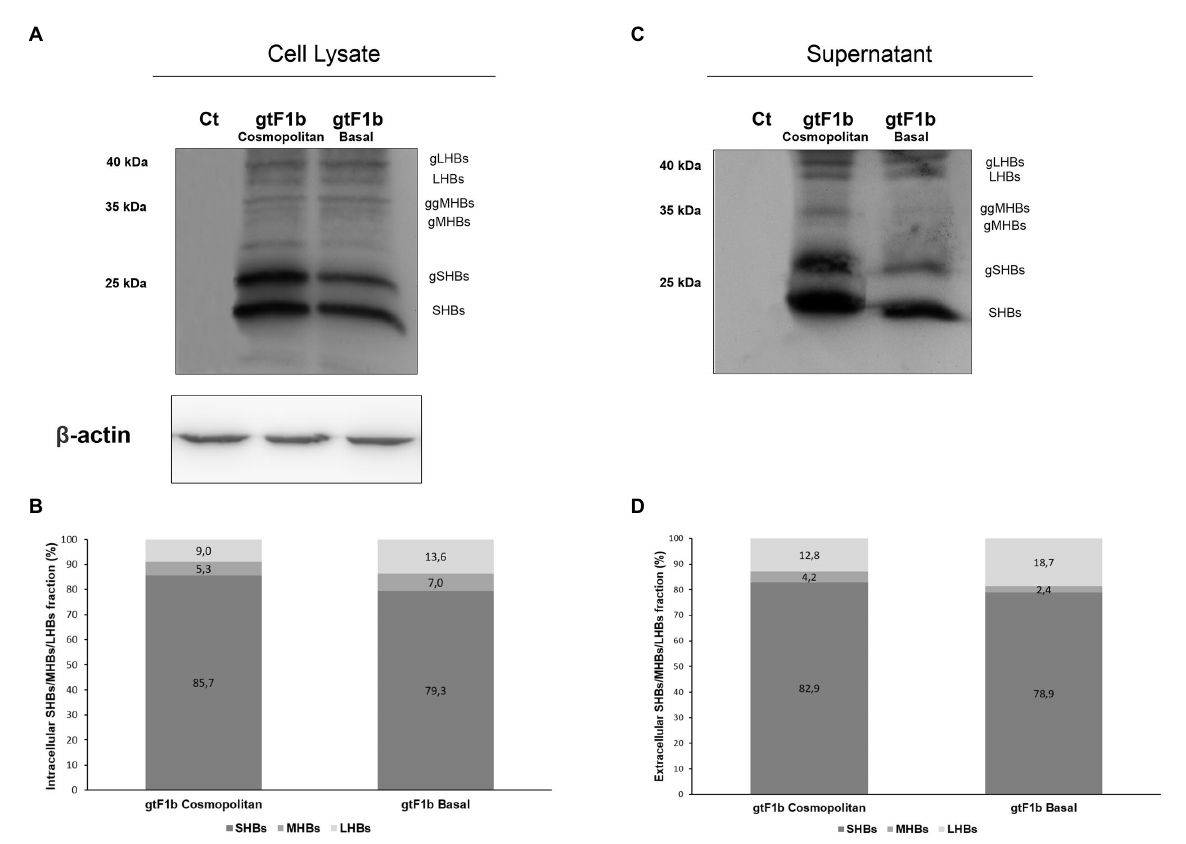
FIGURE 5 Relative composition of HBsAg proteins of gtF1b Cosmopolitan and gtF1b Basal variants. HuH-7 cells were transfected with linear full-length HBV genomes of gtF1b Cosmopolitan and gtF1b Basal variants. Three days’ post-transfection, cellular lysates (A) and the supernatants (C) were analyzed by Western Blot, using a SHBs-specific monoclonal (HB01) antibody. SHBs and LHBs occur in unglycosylated (LHBs and SHBs) and glycosylated (gLHBs and gSHBs) forms, while MHBs occurs in glycosylated (gMHBs) and double glycosylated (ggMHBs) forms. (B) Intracellular and (D) extracellular LHBs/MHBs/SHBs ratio was determined. Ct: cell transfected with pUC19 empty vector